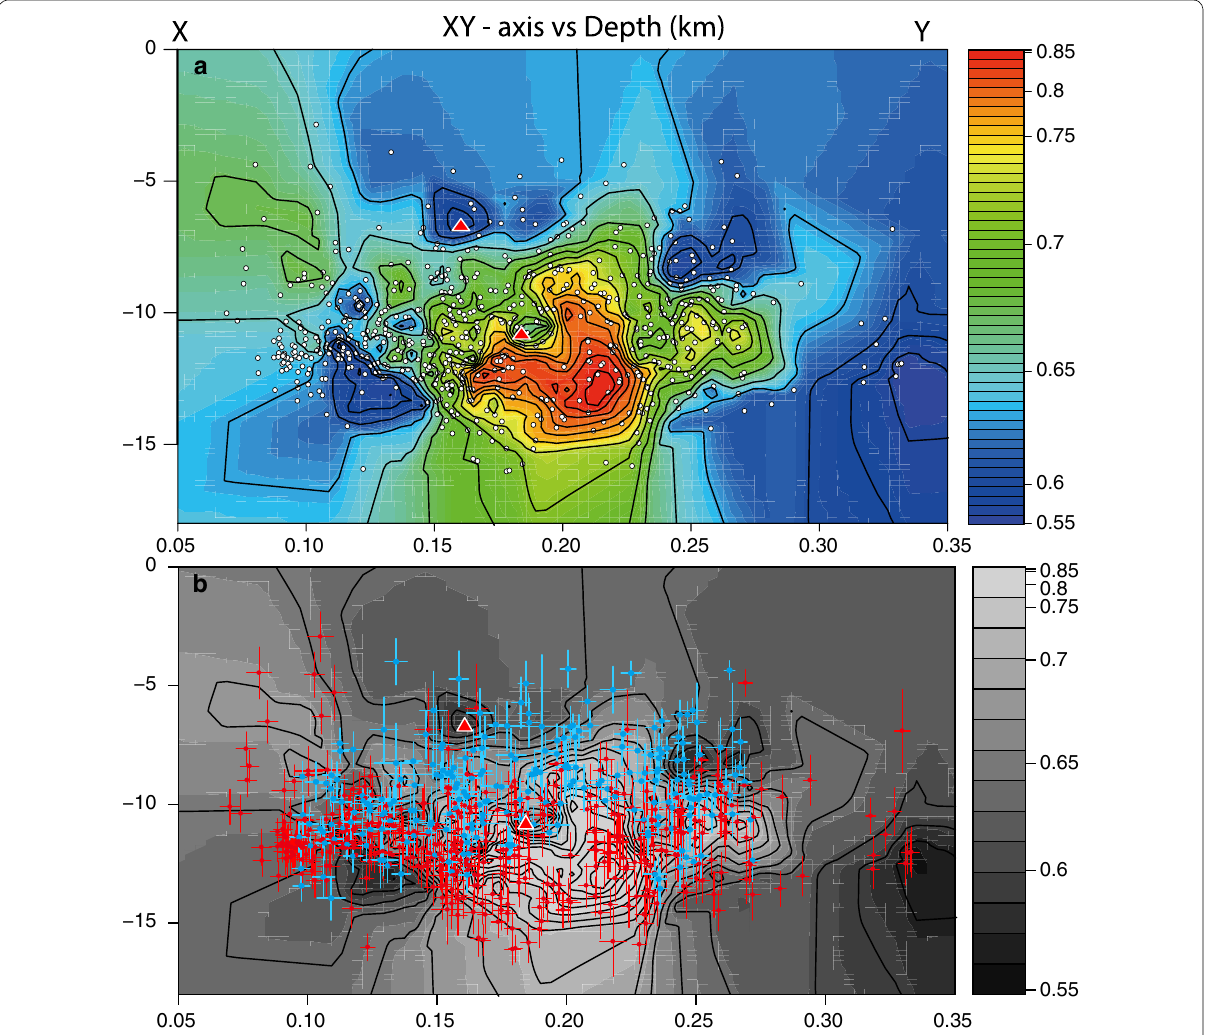
Fig. 12 The vertical b -value variation of foreshocks. a The white dots represent the hypocenters of the foreshock sequence projected onto the X–Y lateral plane (in Fig. 11). Colors and contours show the b -value distribution. The contours are in increments of 0.02. Red triangles indicate the hypo- centers of the M6.5 and M6.4 earthquakes in order from the shallow side. b Blue dots with error bars represent the hypocenters of the foreshocks prior to the M6.4 foreshock, and red dots with error bars represent the hypocenters of the foreshocks after the M6.4